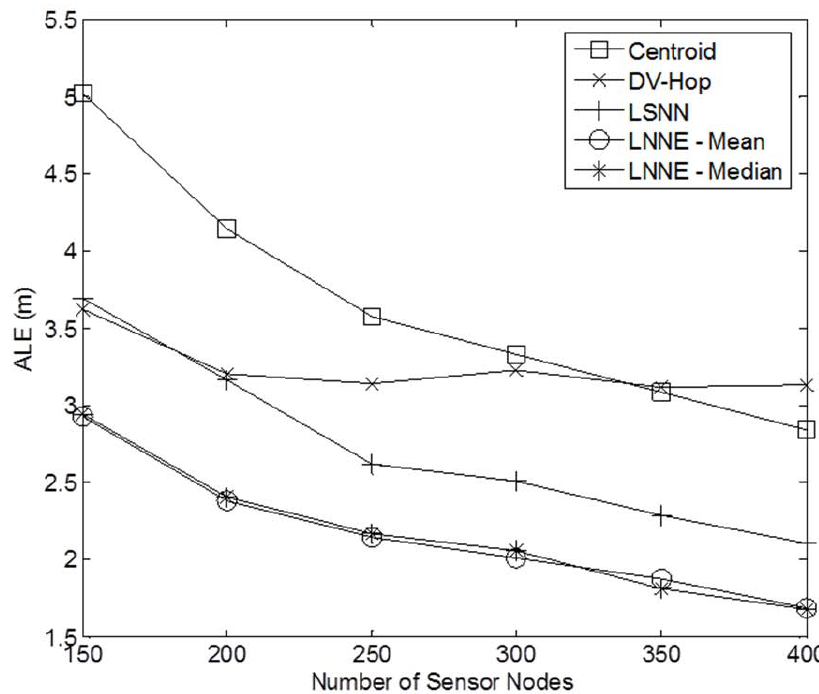
Figure 6. Performance comparison among different network densities ( N = 150 to 400, beacon ratio = 0.2, no coverage